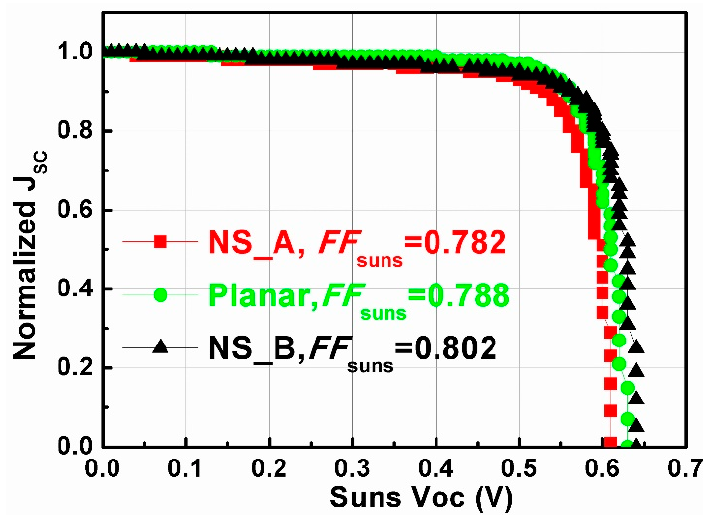
Figure 7. The V OC and FF of the three groups of cells under the condition of ideal electrode contact (R S = 0). The figure is normalized to J SC . The suns V OC values here are 613, 630, and 643 mV, respectively. To enhance the electrode contact of the nanotextured solar cells, light-induced plating (LIP) was introduced [23,24] for all three groups of solar cells. This technique can fill the voids along the electrode–silicon interface and reduce the contact resistance. Schematic images and SEM photographs of the interface before and after LIP are shown in Figure 8.